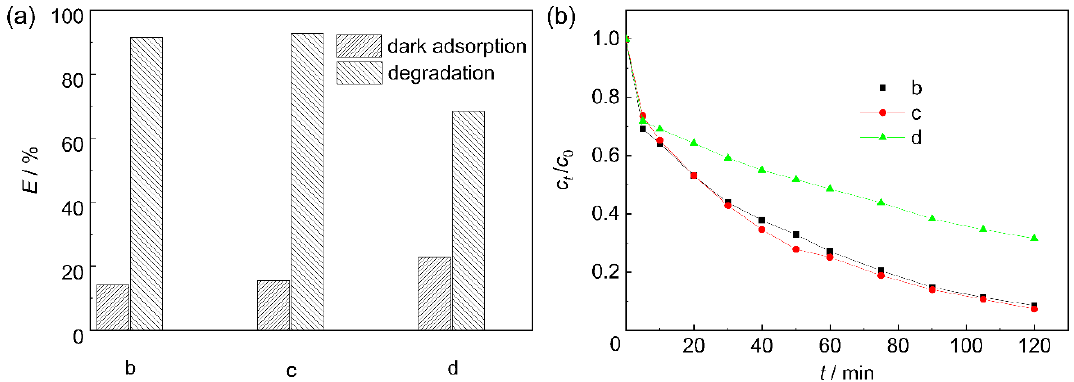
Figure 5. Effect of mass ratio of ZnO to bone char of ZnO/bone char photocatalyst on: ( a ) dark adsorption and degradation, and ( b ) degradation behavior for methylene blue.